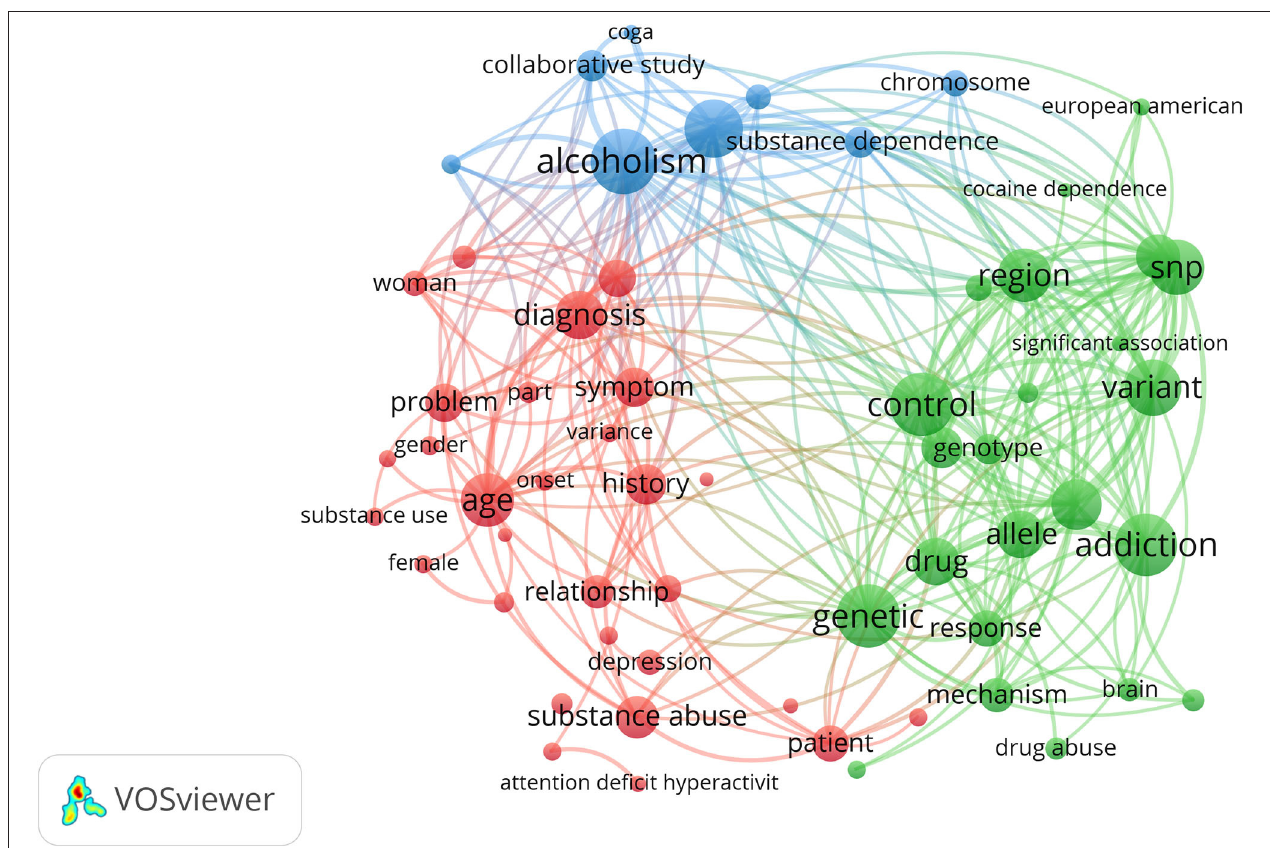
FIGURE 5 | Co-occurrence network of terms of substance-related disorders publications, from 1997 to 2018. Terms are automatically extracted from titles and abstracts and divided into three clusters by natural language processing techniques of